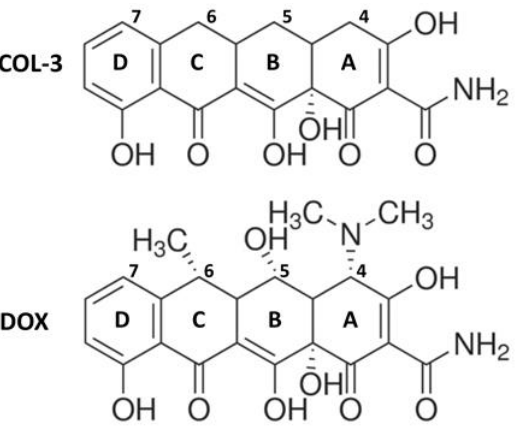
Figure 1. Chemical structures of the non-antibiotic tetracycline COL-3 and of its parent compound DOX. COL-3 differs from DOX by the absence of the DCBA naphthacene core structure of dimethylamino-, hydroxyl-, and methyl- groups in C-4, C-5, and C-6, respectively. The loss of antimicrobial activity specifically results from the removal of the dimethylamino group at the C4 position.